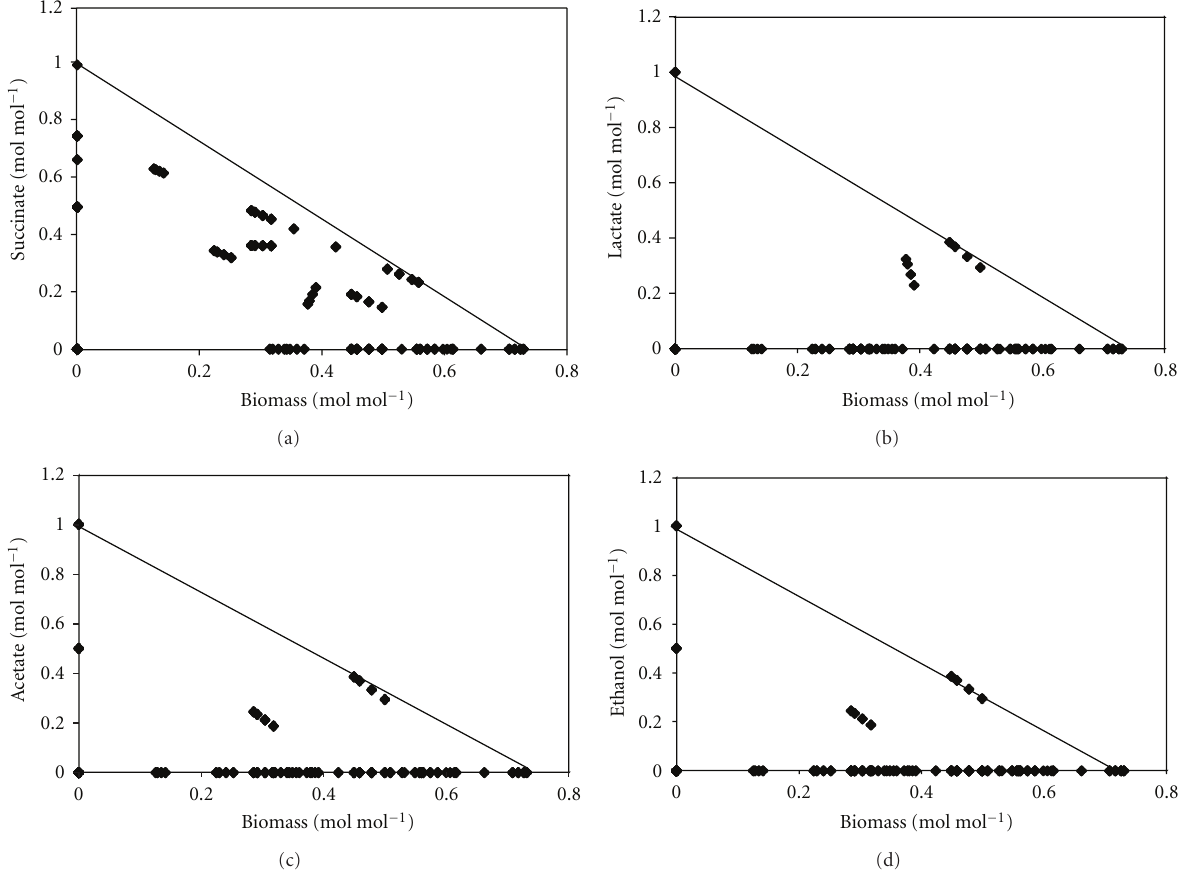
Figure 5: Relationship between the yields of biomass and byproducts for the obtained elementary modes of E. coli under aerobic conditions. (a) Succinate, (b) Lactate, (c) Acetate, and (d) Ethanol. The enclosed regions represent the possible solution space. The fluxes were normalized by glycerol uptake rate and expressed as mol/mol (glycerol).